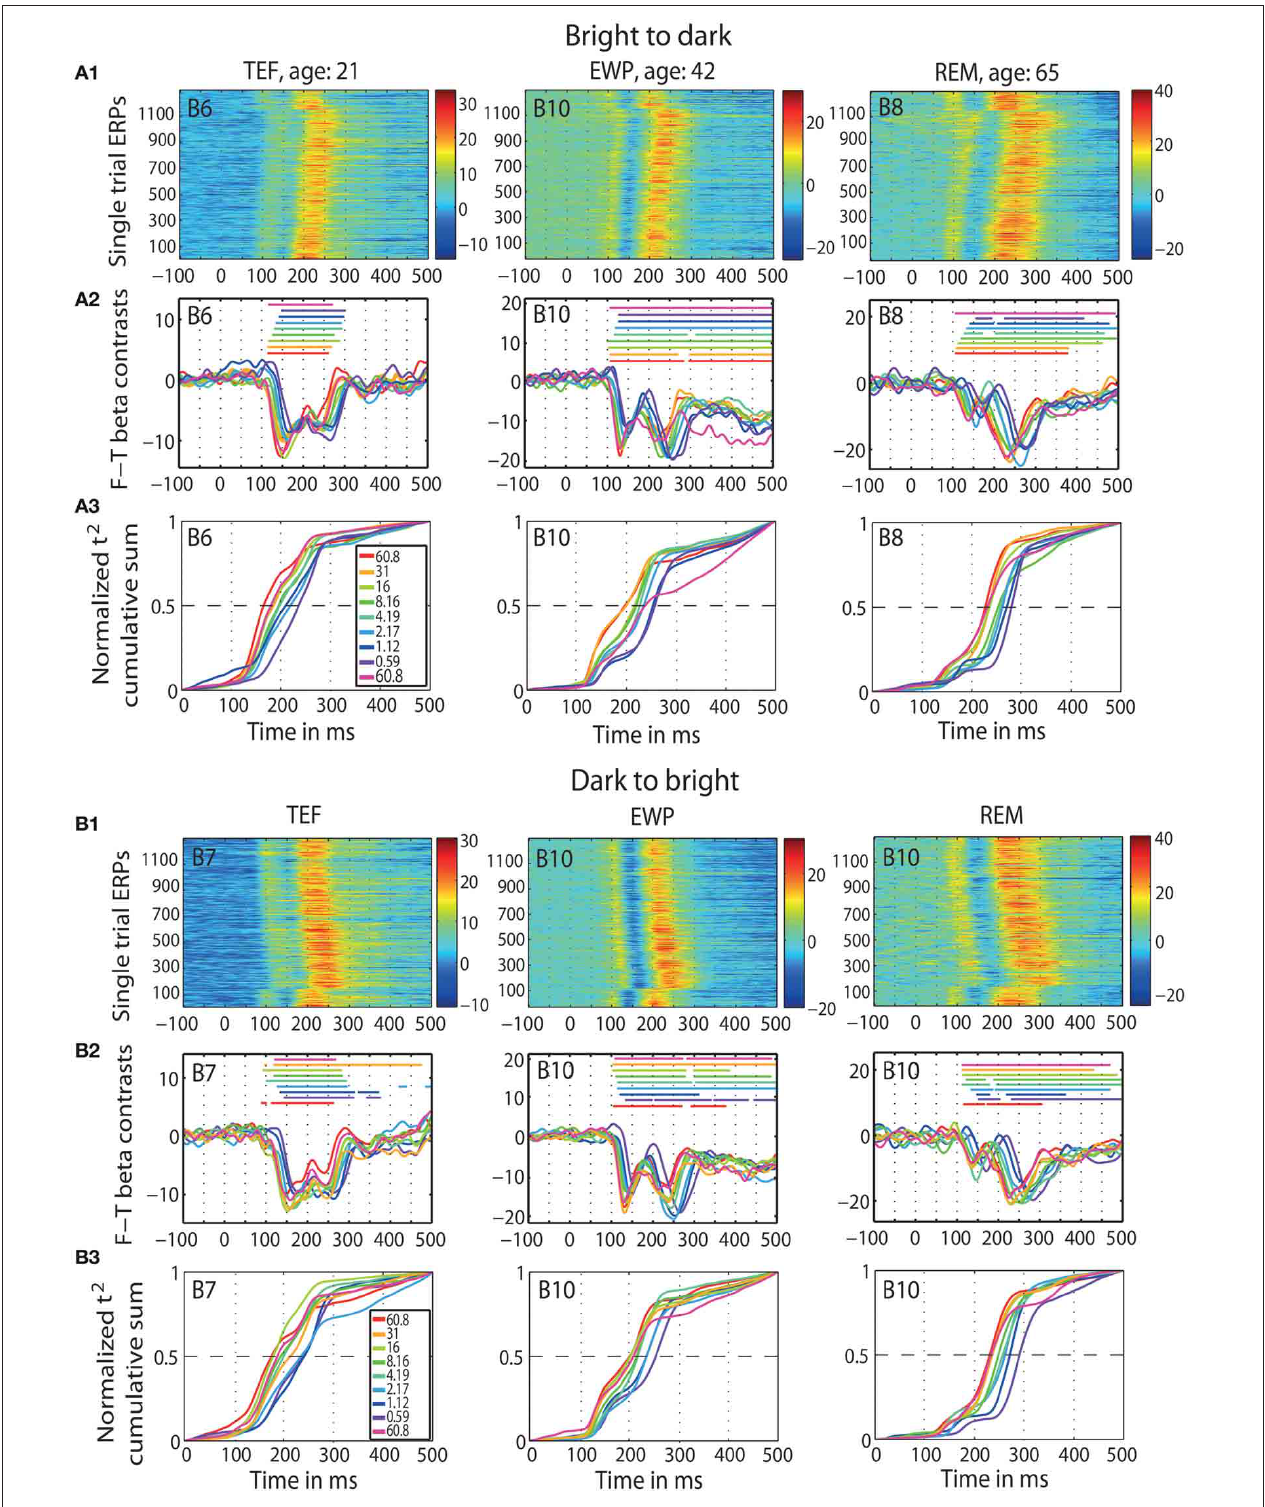
map is provided in Figure S4 . ( A1 and B1 ) Single trial ERPs, in µ V. ( A2 and B2 ) Time-courses of contrasts between face and texture beta-coefficients for each luminance level; horizontal lines indicate significant contrasts. ( A3 and B3 ) Normalized t 2 cumulative sums at each luminance level.